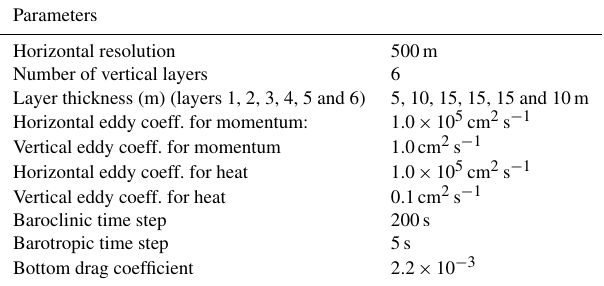
Table 1. The model parameters chosen for the wind-driven circula- tion